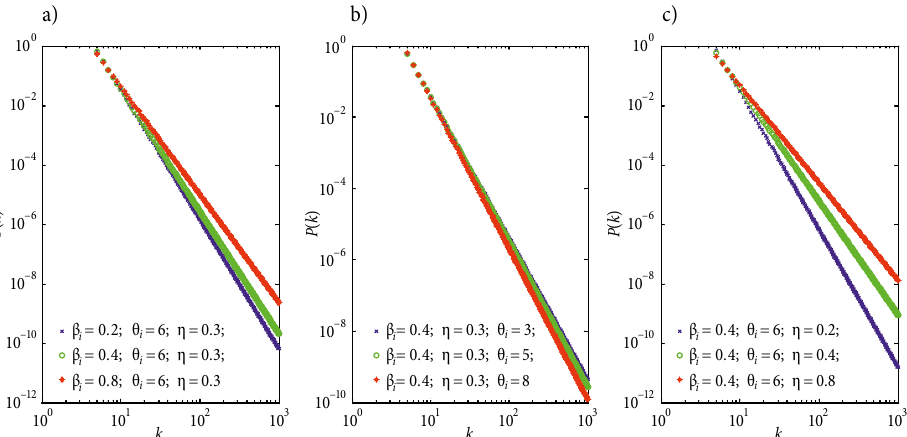
Fig. 5. The path distribution of nodes P ( k ) infected with credit risk at network size M = 1000 of credit risk contagion and different values of b